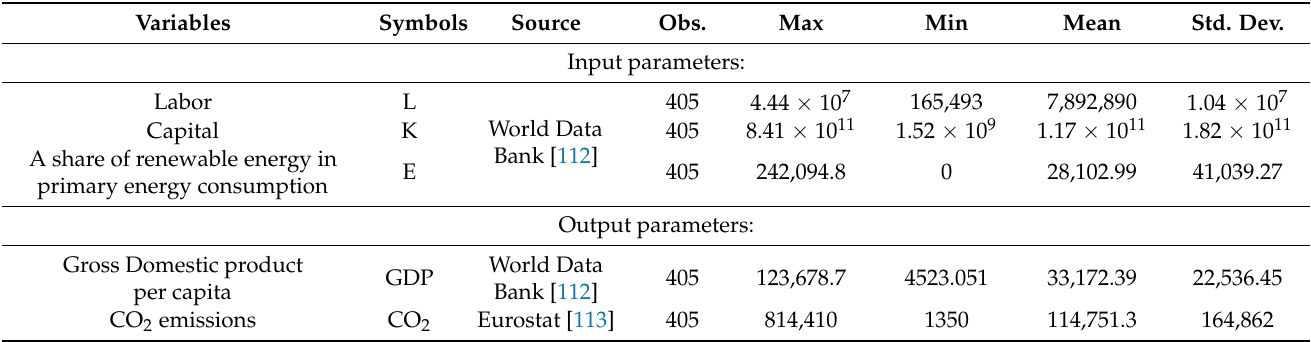
Table 1. Variables, source, and descriptive